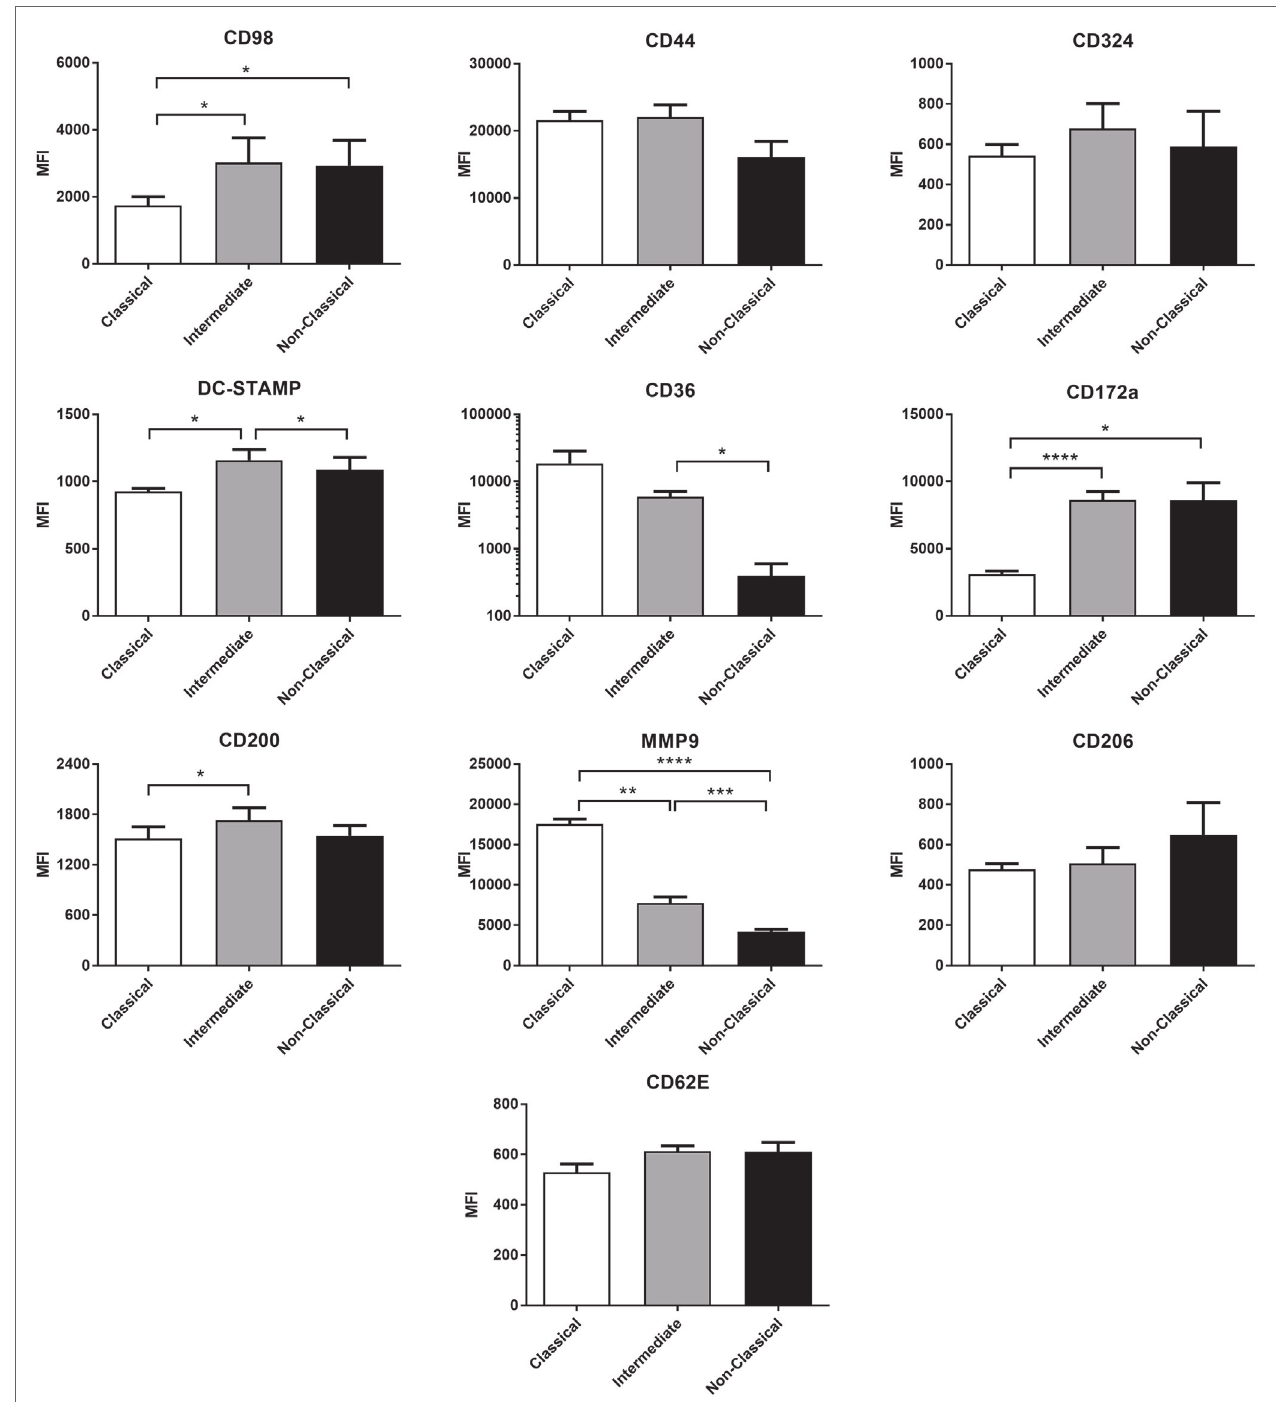
FigUre 9 | The expression of fusion­related molecules is higher on intermediate monocyte subset. Freshly isolated monocytes were analyzed for fusion protein expression on subsets using flow cytometry. Bars indicate means ± SD from three separate experiments. Significance of difference between subsets was tested with a one­way ANOVA and a Tukey multiple comparisons